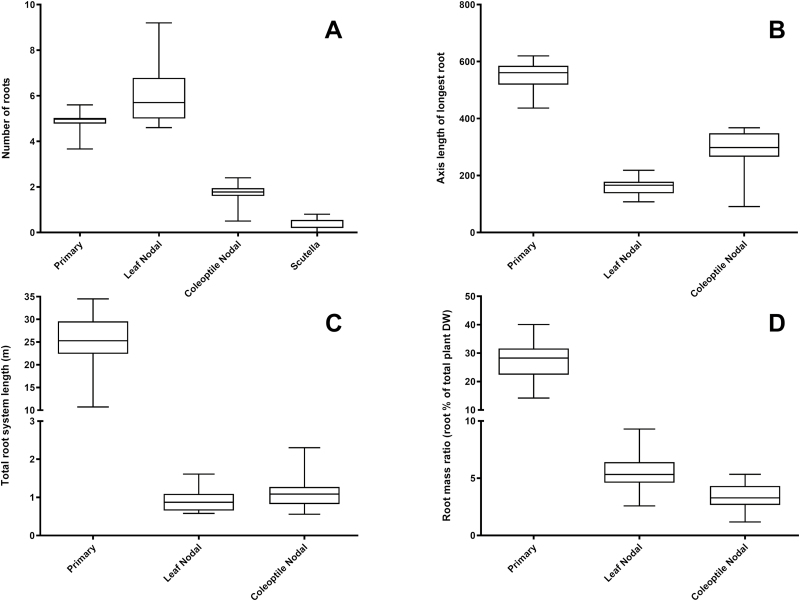
Variation in root traits for 20 wheat varieties at 27 DAS; number of roots (A), axis length of longest root (B), total root system length (C), and root mass ratio. Number of roots (A) and axis length of the longest root (B) were determined manually at time of harvest. Total root system length (C) was determined by scanning root systems and analysing with WinRhizo software. Root mass ratio (D) was determined by the dry mass of root to shoot tissue. Data from 18 wheat genotypes grown under non-limiting conditions in a 0.5 m deep tubes (n=5/genotype).